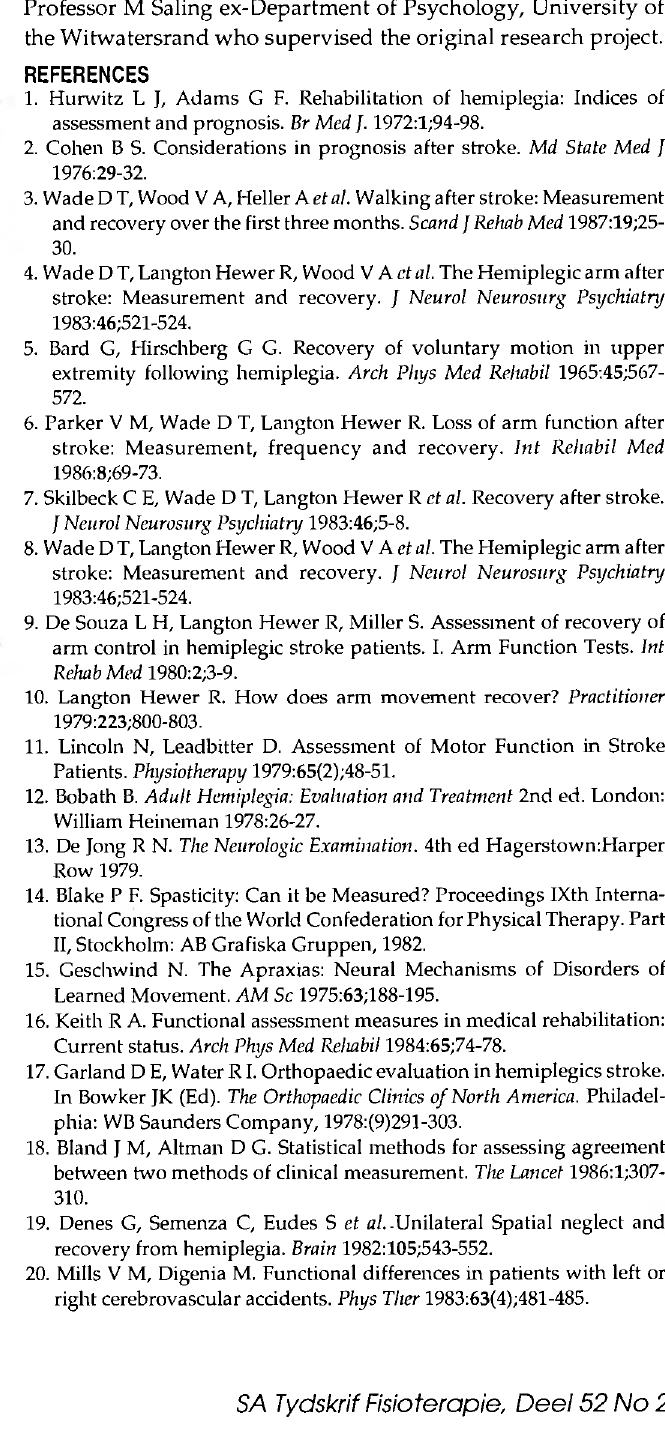
Figure 3: Correlation between spontaneous _____________________and observed